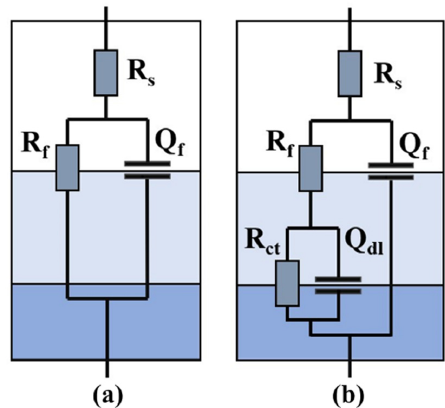
Figure 7. Electrochemical equivalent circuits for fitting the measured impedance data of (a) the FLAR samples and (b) other samples. Table 5. Fitting results of EIS for 8 samples in 0.5 mol/L NaCl for 72 h.